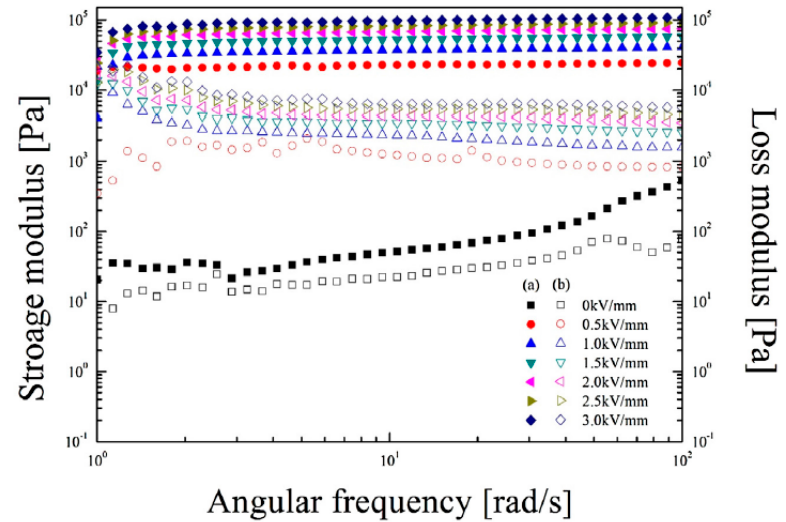
Figure 10. Storage modulus (filled symbols) vs. angular frequency and loss modulus (open symbols) vs. angular frequency for the phosphate MCC ER fluid under a series of external electric field strengths (reprinted from [70]).